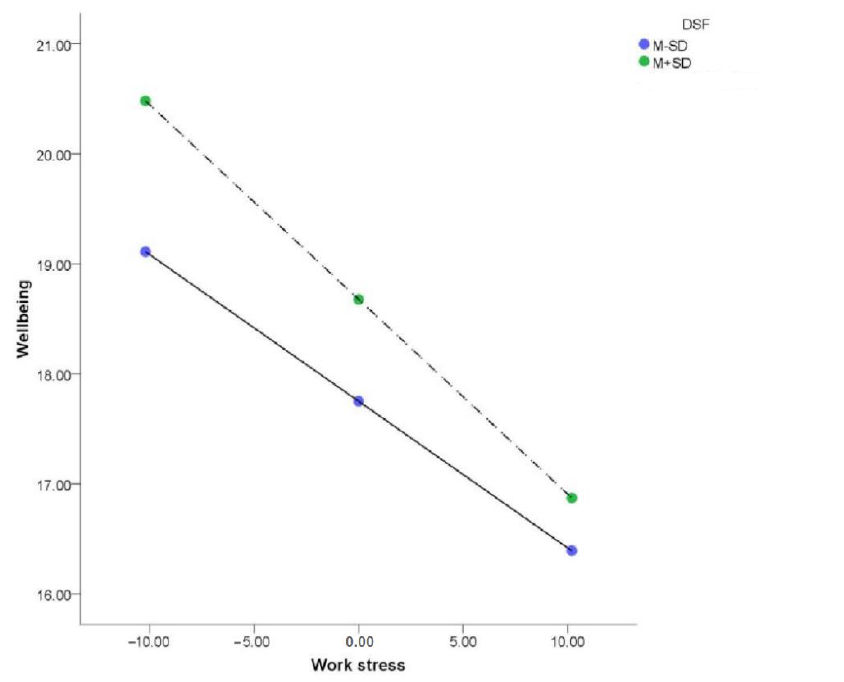
Figure 4. The moderating effect of factor-DSF (detachment from success or